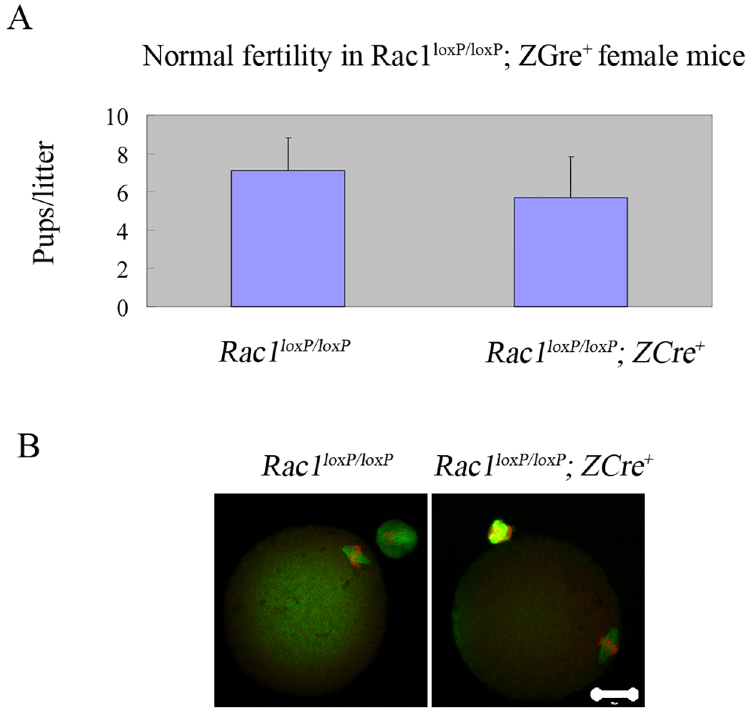
Fig 2. Normal fertility and MII eggs in female mice with oocyte-specific deletion of Rac1 . (A) Comparison of the averagenumberof pups per litter per female mice during a periodof 6 months between Rac1 loxP/loxP ; ZCre + (n = 4) and Rac1 loxP/loxP mice (n = 3). P > 0.05.The data are mean ± SEM. (B) Normal spindle/chromosomes in Rac1 loxP/loxP ; ZCre + MII eggs. Ovulated eggss were fixed and stainedwith anti- α - tubulin-FITC antibody (green)and counterstained with PI to visualizeDNA (red). Experiments were repeated at least three times and representative images were